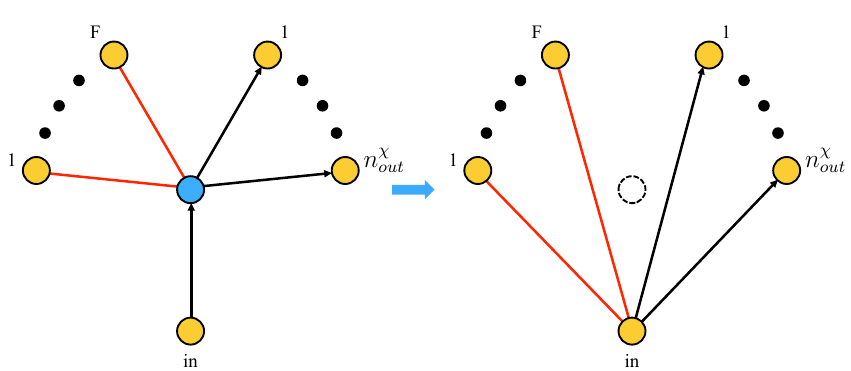
Figure 19. A node with a single incoming chiral (cid:12)eld corresponds to a bubble. Due to anomaly cancellation, n (cid:31) = F + 1. The bubble can be removed by formal triality. We can alternatively out think of this process as giving a non-zero vev to the incoming